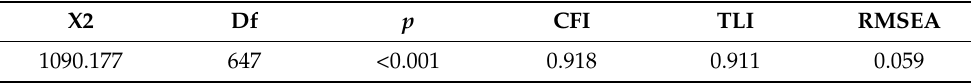
Table 6. The structural model fit.